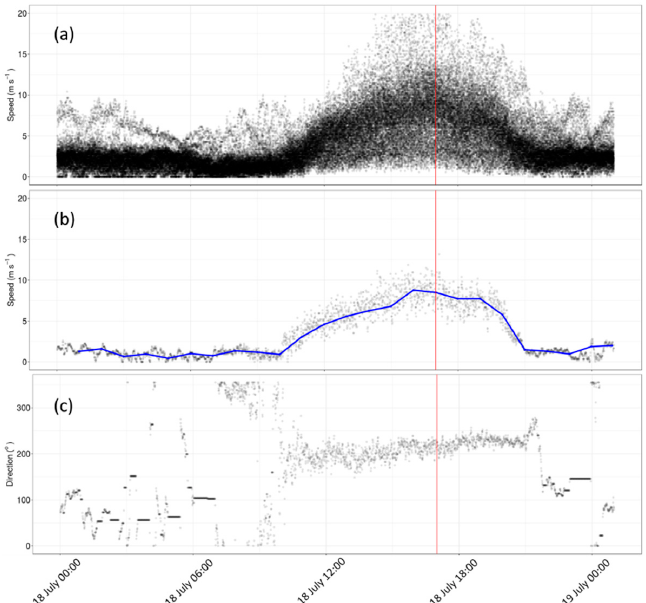
Figure 6. Instantaneous wind speeds measured at Big Southern Butte on 18 July 2010 at ( a ) all sensors and ( b ) sensor R2 and ( c ) instantaneous wind direction measured at sensor R2 on 18 July 2010. The blue line indicates 10 min averaged wind speed at the top of each hour. The red line indicates 1700